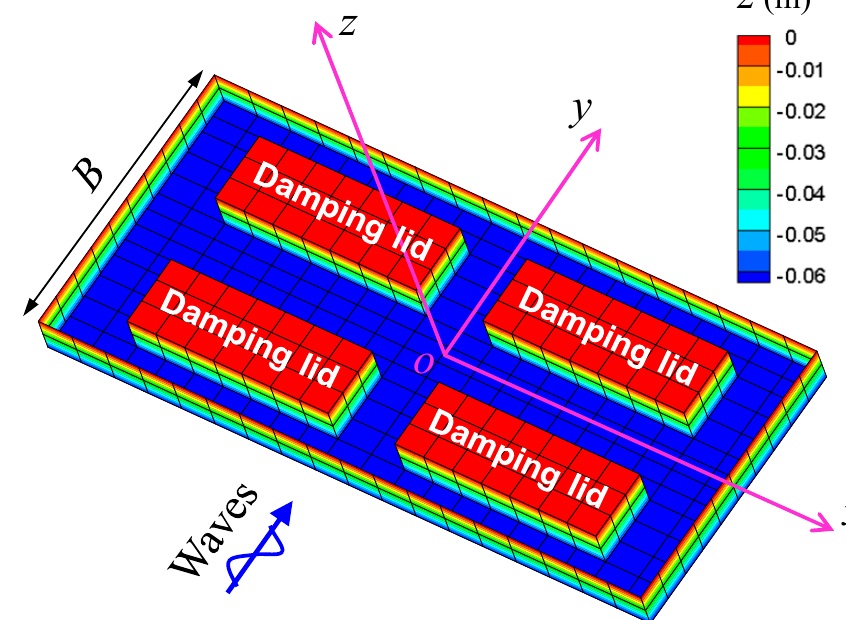
Figure 15. Illustration of the damping lids placed on water surfaces in moonpools.